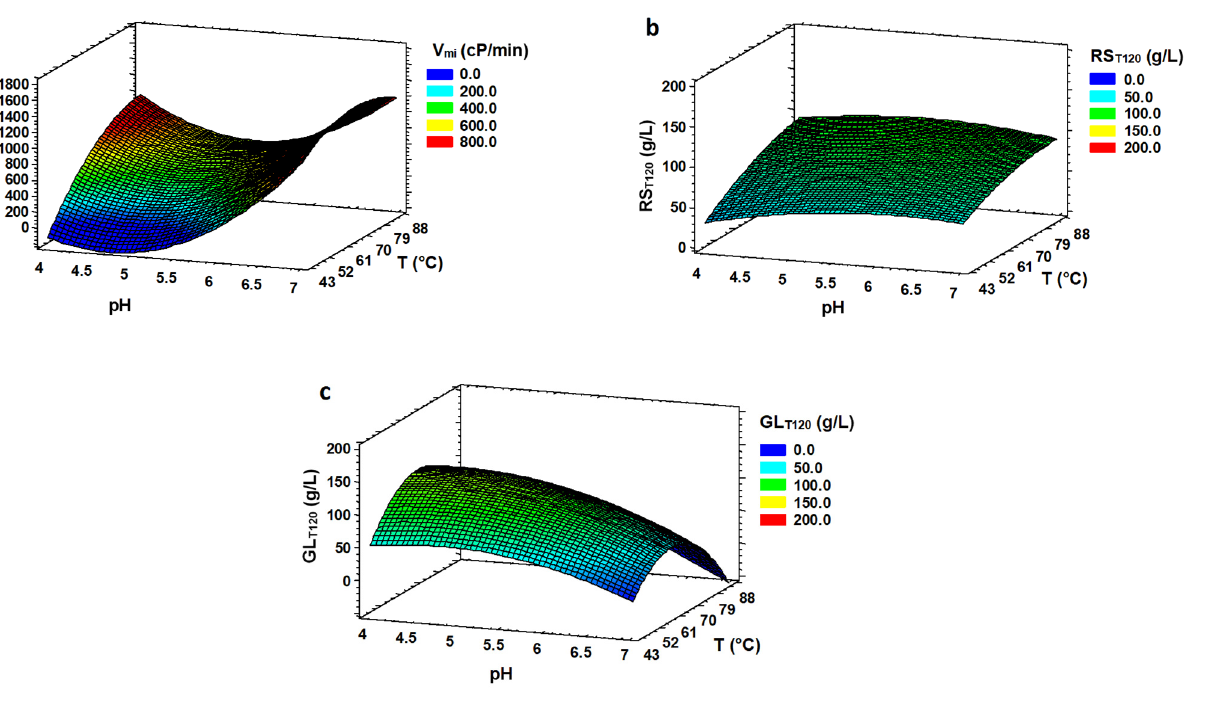
Figure 2. Response surface plots for the sequential hydrolysis. LIQ and SAC phases as function of temperature and pH for ( a ) slope of the viscosity curve (V mi ), ( b ) theoretical reducing sugar concentration at 120 min (RS T120 ) and ( c ) theoretical glucose concentration at 120 min (GL T120 ).